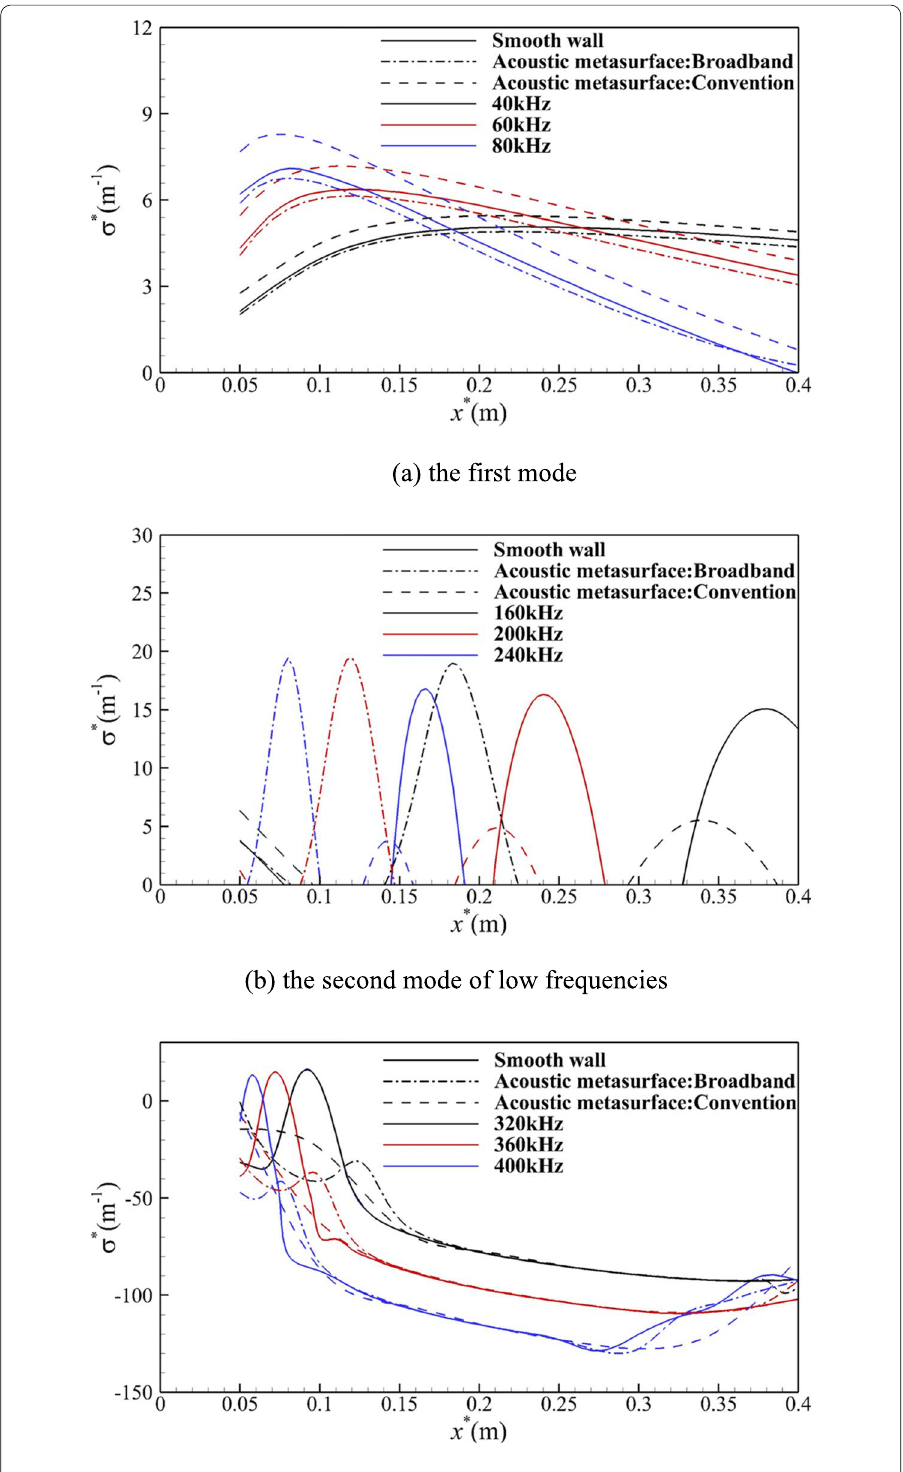
Fig. 7 Dimensional growth rates of unstable modes in the BL along different surfaces. The line shapes are used to differentiate the metasurfaces, and the colors are used to differentiate frequencies. ( a ) the first mode. ( b ) the second mode of low frequencies. ( c ) the second mode of high